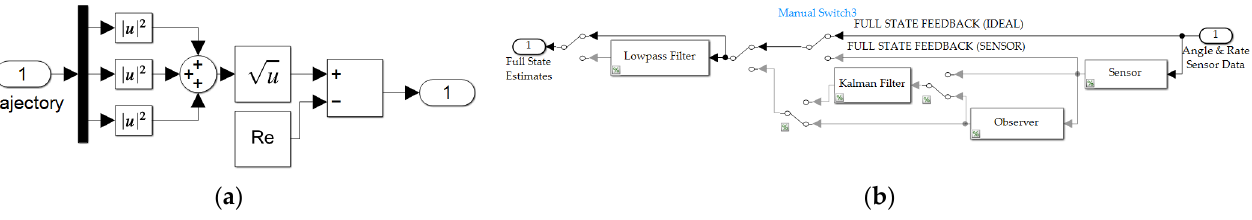
Figure A8. SIMULINK subsystems in Figure A1 ( a ) Altitude Calculation subsystem; ( b ) Sensors and Observers subsystem (bypassed).